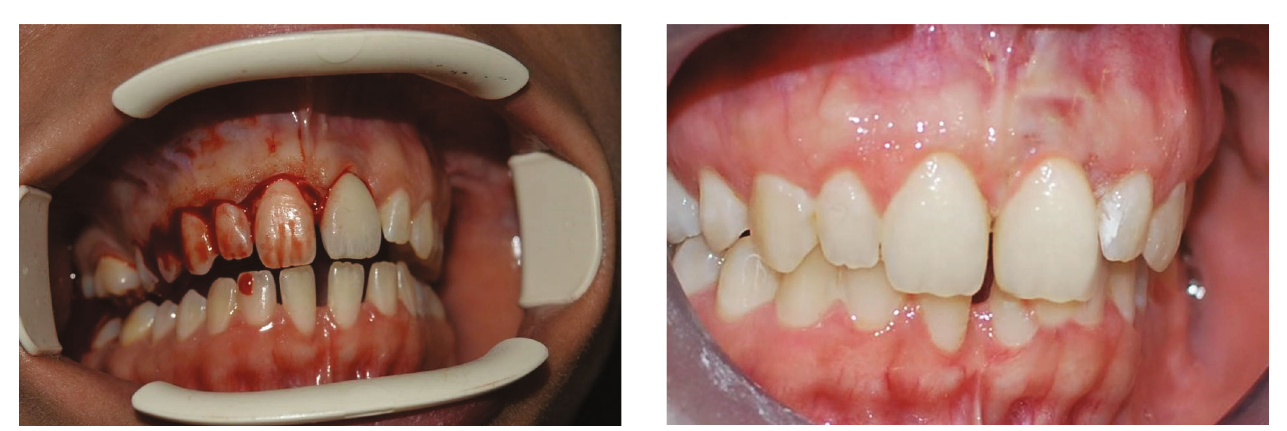
Figure 5: Using a 15c scalpel, a full depth fl ap was created with a primary nonmarginal incision placed 2mm from the edge and an intrasulcular fi llet incision.